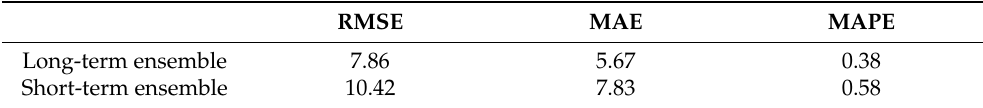
Table 6. Three-year forecasting performance obtained by short-term and long-term learning ensembles. RMSE MAE MAPE Long-term